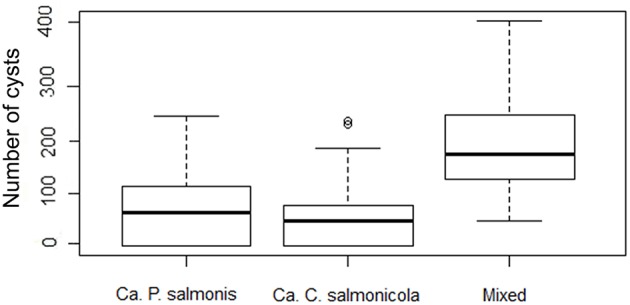
Box Plot of morphology type and number of cysts per gill arch (infection intensity) (note the logarithmic scale in the y axis).